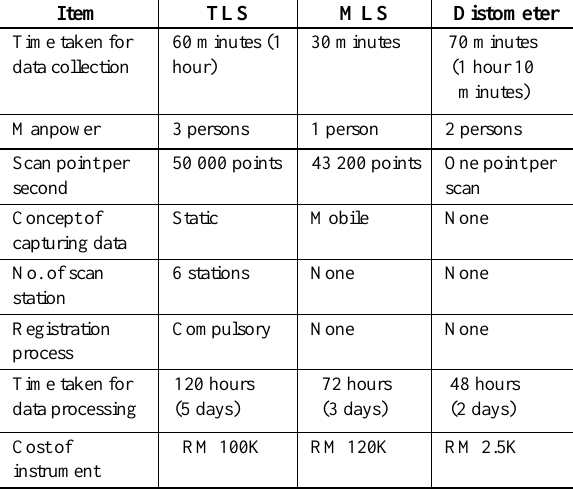
Table 4: General comparison between TLS, MLS and